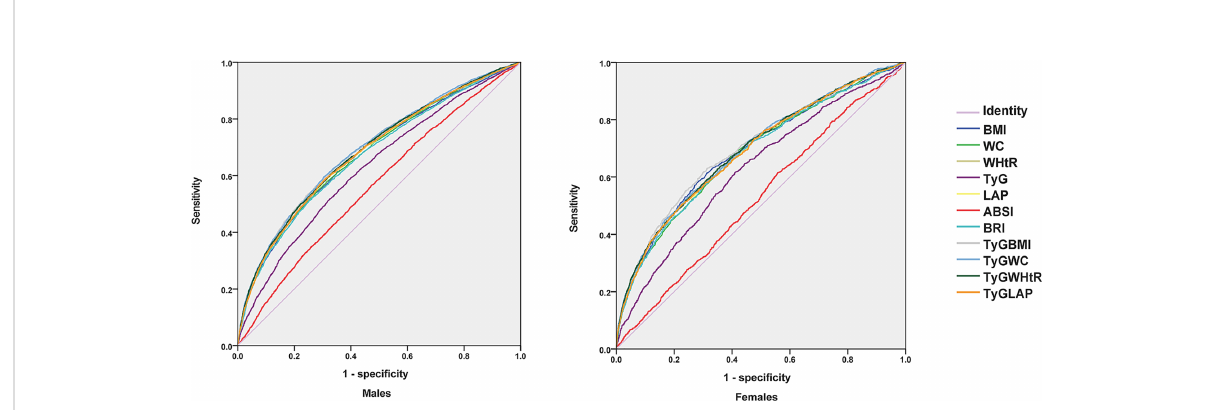
FIGURE 2 Receiver operating characteristic (ROC) curve analysis by sex. TyG index, triglyceride glucose index; BMI, body mass index; WC, waist circumference; WHtR, waist-to-height ratio; LAP index, lipid accumulation product index; ABSI, a body shape index; BRI, body roundness